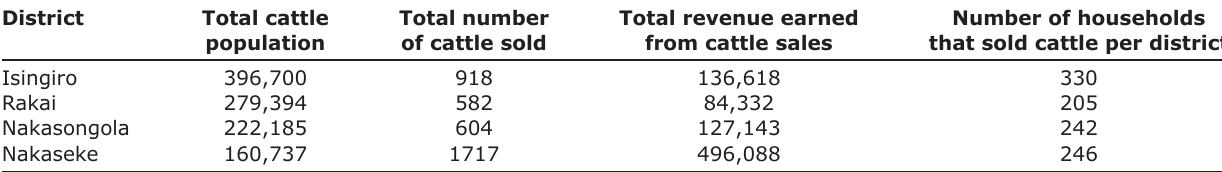
Table-5: Total cattle populations, number of cattle sold, revenue earned (US dollars) from cattle sales, and number of households that sold cattle per district. District Total cattle population